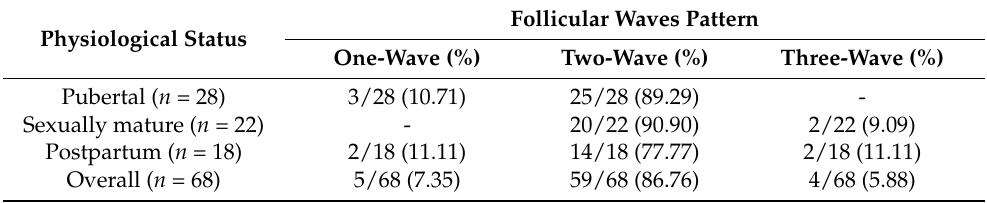
Table 1. The distribution of follicle waves in Chinese crossbred buffaloes with different physiological stages (puberty, mature and